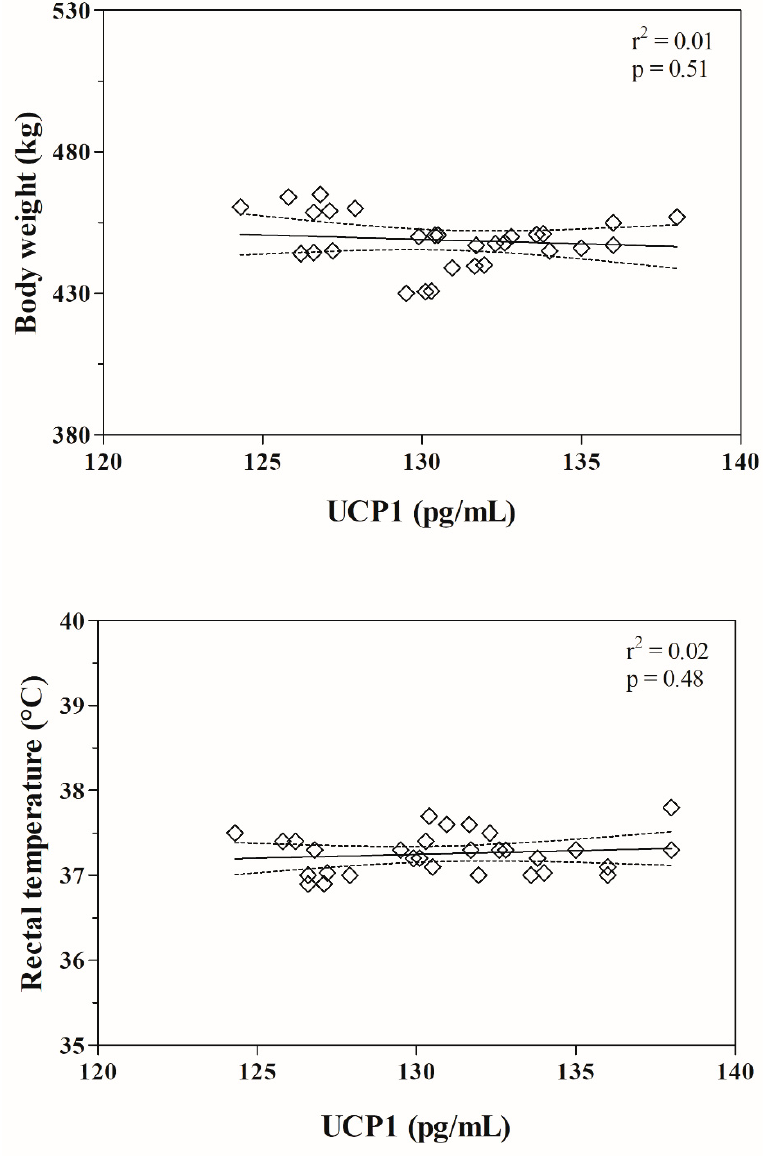
Figure 1. Results of linear regression model between the serum values of mitochondrial uncoupling protein-1 (UCP1) and the values of body weight and rectal temperature recorded in investigated horses.